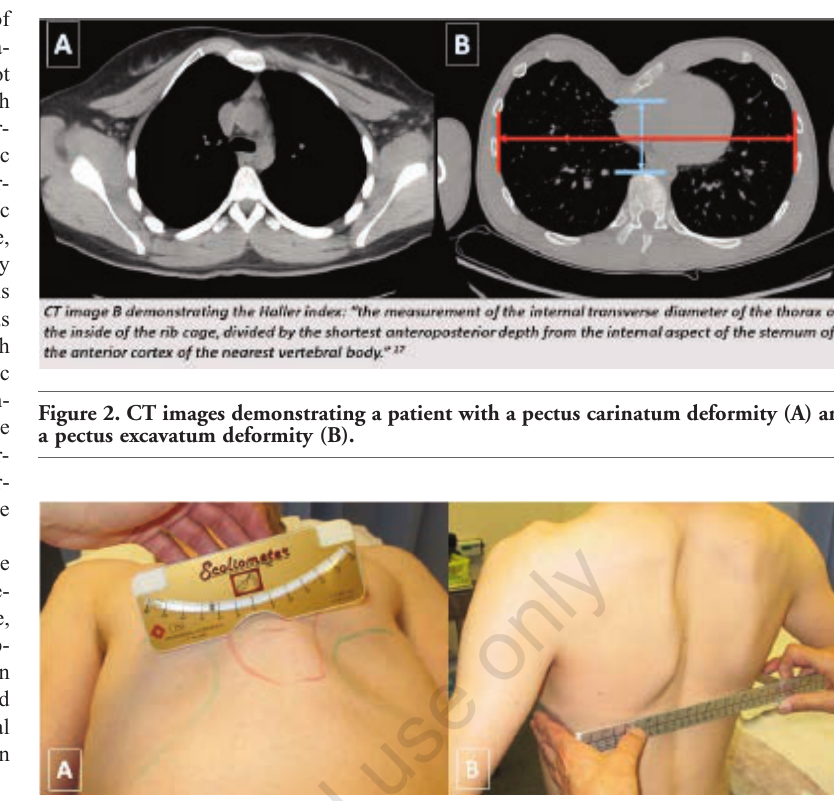
Figure 3. Examination of a pectus carinatum deformity. Measurements including the degree of sternal angulation (A) and the mediolateral chest dimensions (B).